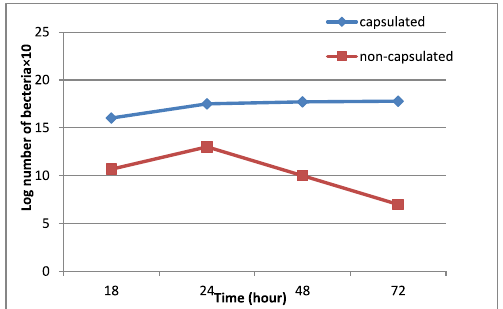
Fig. 4. Viable count of capsulated and non-capsulated K. ozaenae recovered from mice blood. Each dot acts log10 CFU per of blood (mean) for 3